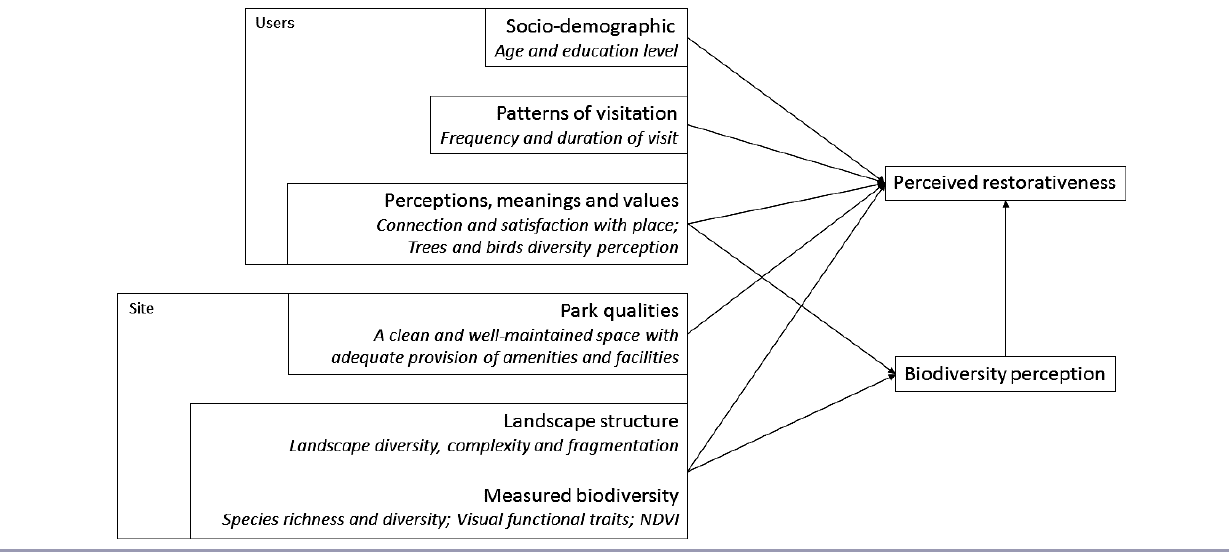
Fig. 1. Diagrammatic representation of the approach used to model perceived restorativeness and biodiversity perception, including user and site variables.